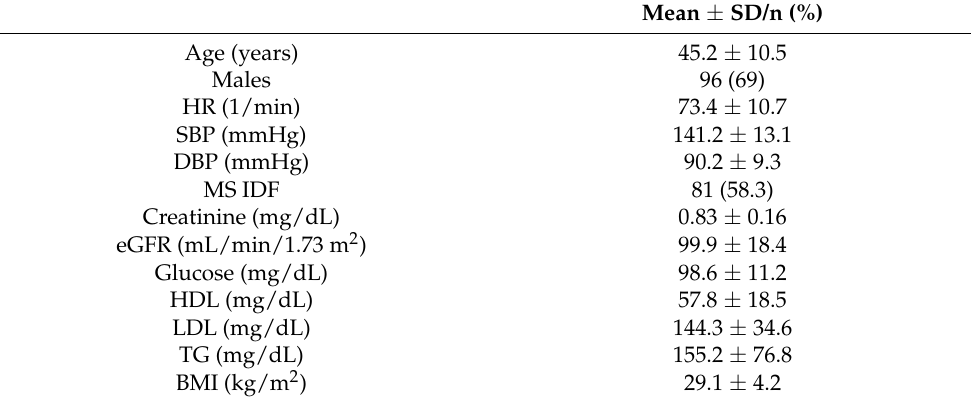
Table 1. Baseline clinical data.